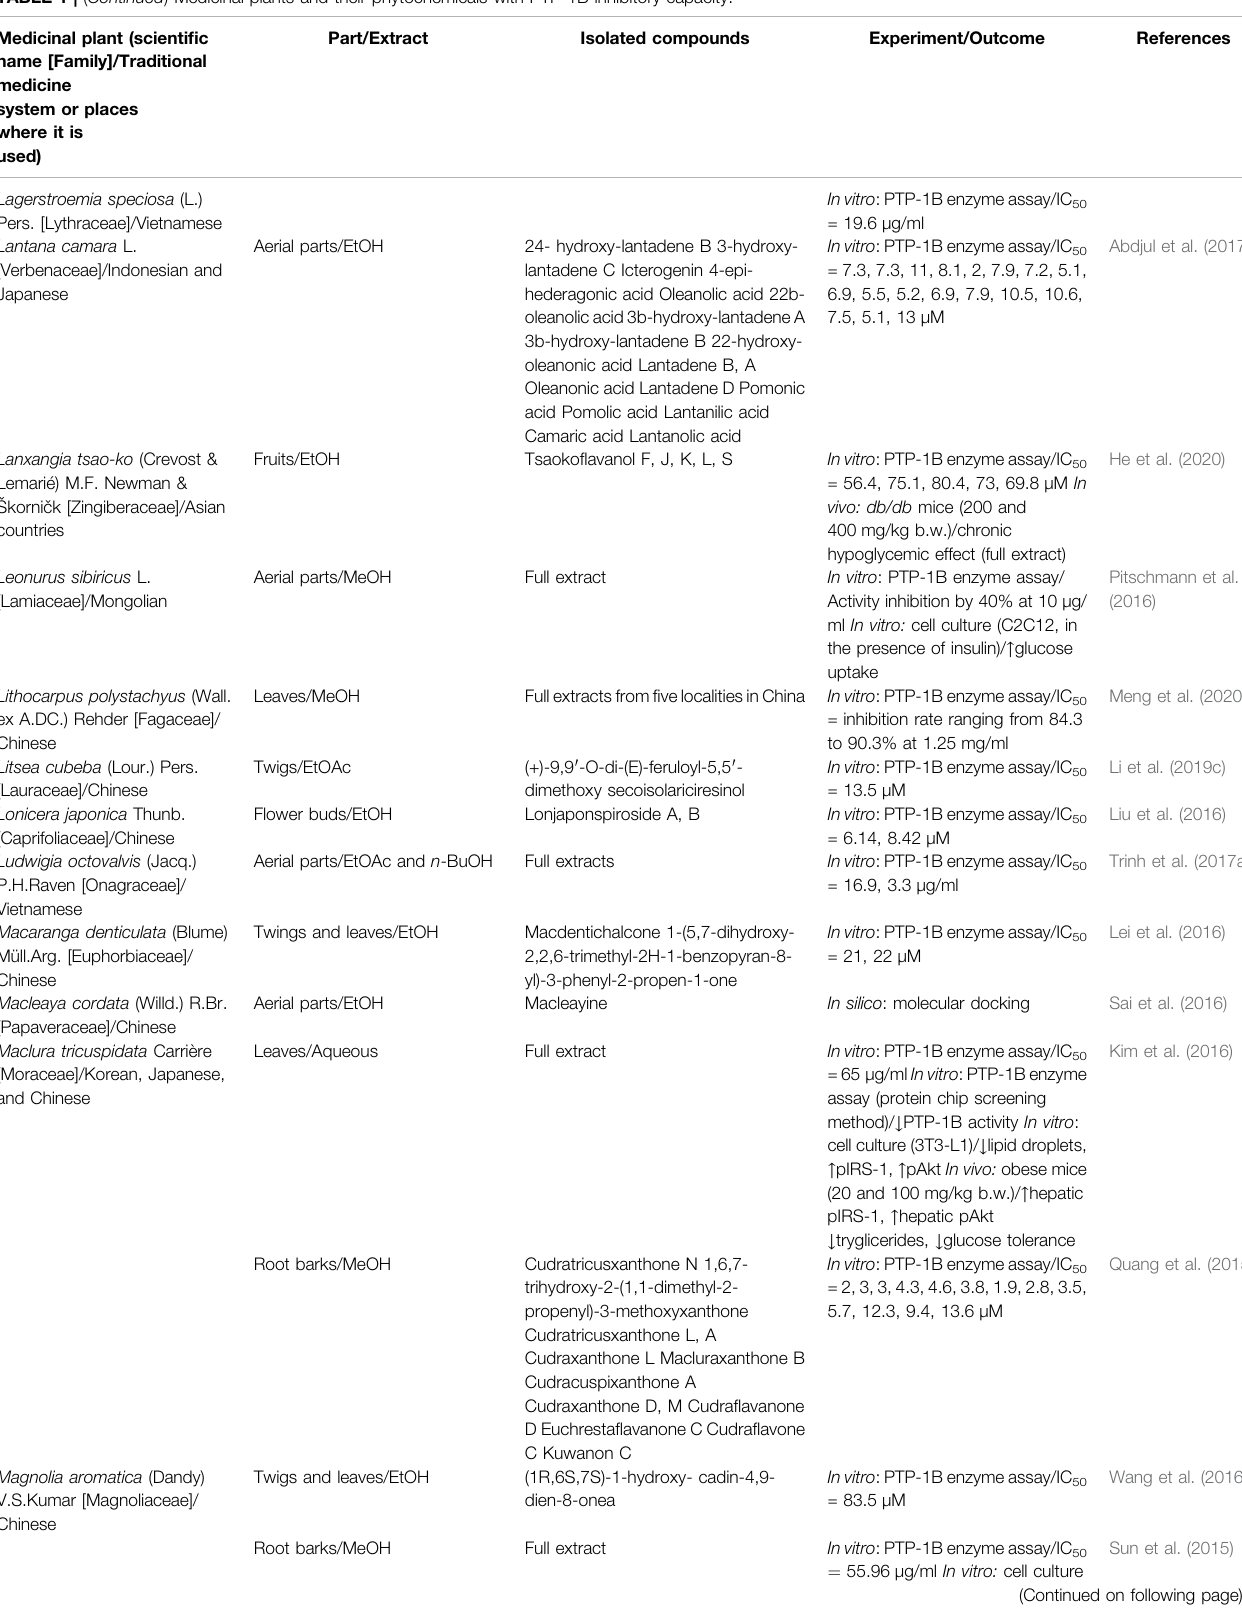
Medicinal plant (scienti fi c name